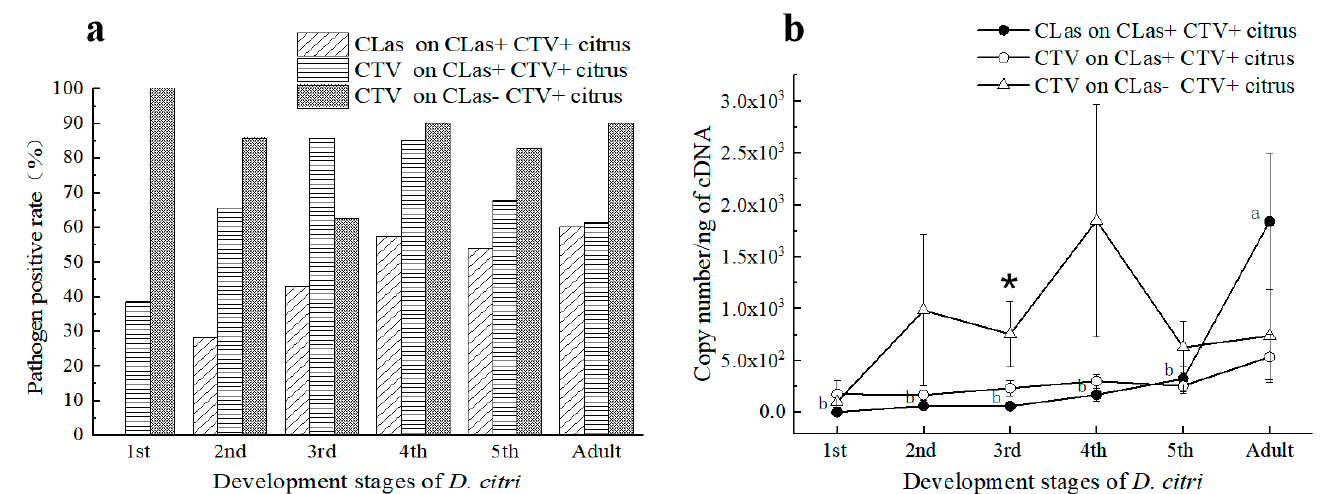
Figure 2. Presence and titers of ‘ Candidatus Liberibacter asiaticus’ (CLas) and Citrus tristeza virus (CTV) in D . citri from CLas–infected and uninfected trees in citrus orchards. ( a ) Percentage of different stages’ D . citri that tested positive for CLas or CTV; ( b ) The average copy numbers of CLas or CTV carried by D . citri at different developmental stages; CLas+: CLas positive; CLas − : CLas negative; CTV+: CTV positive; CLas+CTV+ Citrus: Citrus plants infected by both CLas and CTV; CLas-CTV+ Citrus: Citrus plant infected by CTV but not by CLas. The data were subjected to statistical analysis by one–way analysis of variance (ANOVA) followed by Duncan’s new multiple range test. Different letters in the figure indicate significant differences at p < 0.05 level. *: Statistical significance in 95% confidence interval ( p = 0.05) by independent sample t -test.